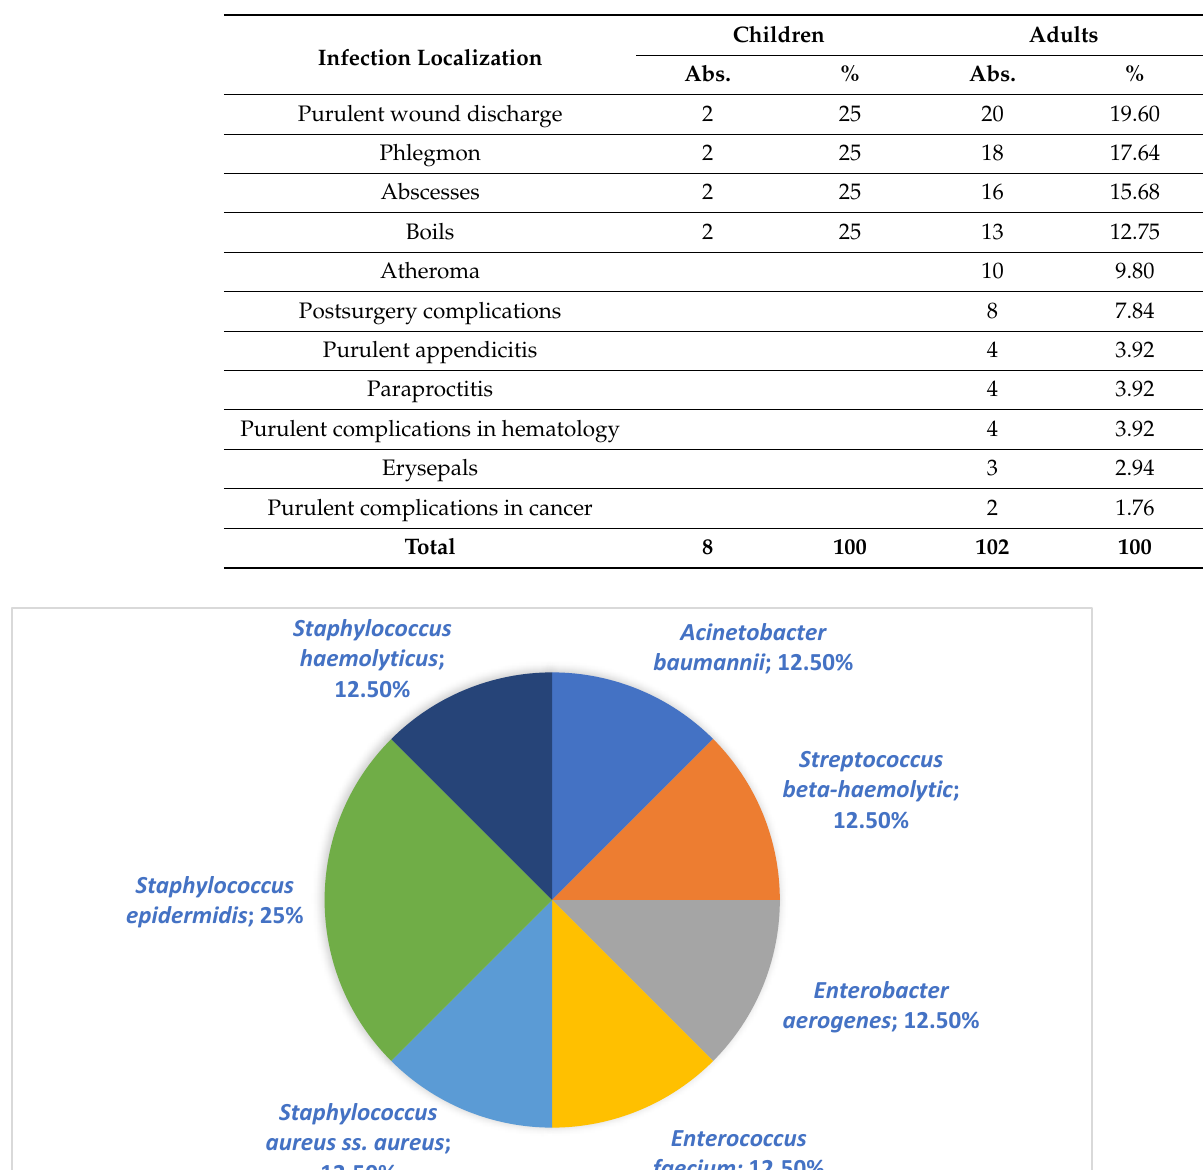
Figure 1. Etiology of soft tissue infections in Karaganda, Kazakhstan, 2018 – 2020, children.